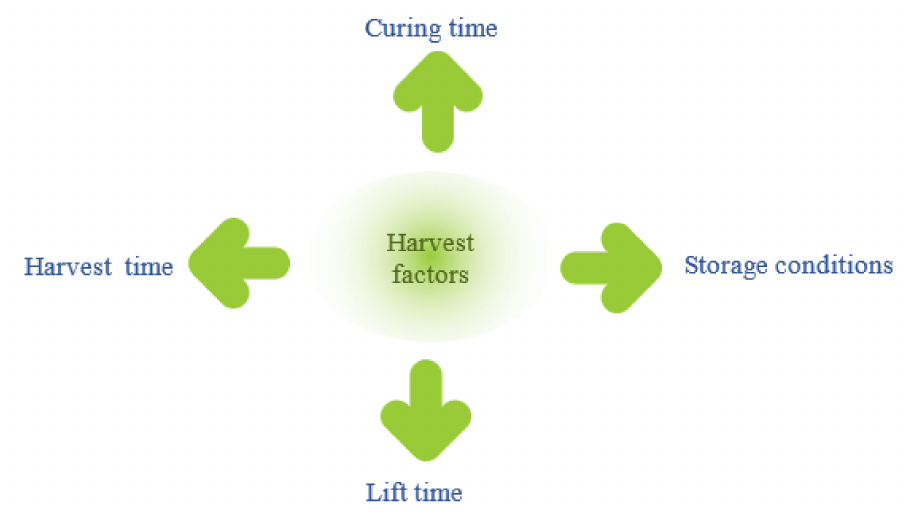
Figure 2. Post-harvest factor changes in the contents of the phenolic compounds in